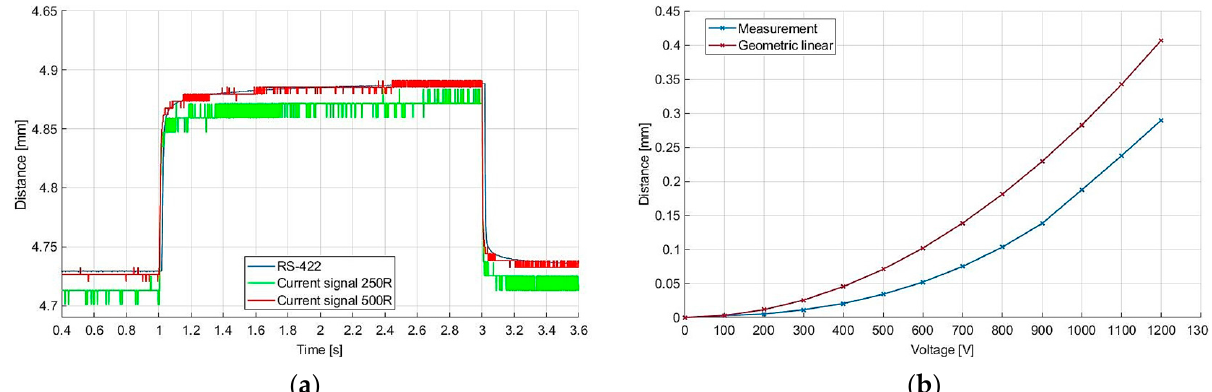
Figure 7. Distance measurement ( a ) absolute with di ff erent interfaces ( b ) relative with theoretical comparison.